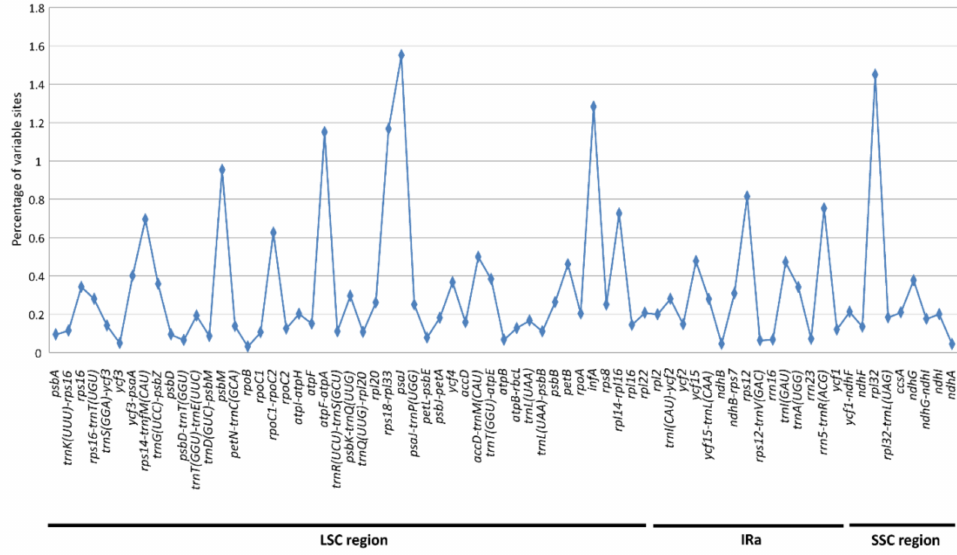
Figure 3. Percentage of variable characters (SNPs and indels) in polymorphic chloroplast loci in Eucommia ulmoides . The homologous loci are oriented according to their locations in the chloroplast